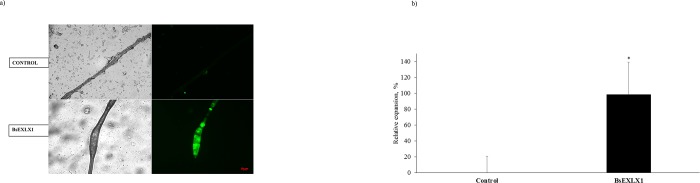
a and b. Effect of a recombinant bacterial expansin-like protein (BsEXLX1) on a) fluorescence microscopy images of cotton fibers treated with citrate buffer without (control) or with recombinant bacterial expansin-like protein (BsEXLX1) (300 μg/g cotton fibers) after incubation for 1 h in triplicate at 50°C and pH 4.0. Images on the left represent transmitted light illumination and, those on the right represent BsEXLX1 immunolocalization with a 20x objective. The scale bar represents 20 μm. b) Relative expansion of cotton fibers (expressed as a percentage of the value for the control). Samples were incubated in triplicate at 50°C and pH 4.0 for 1 hour. The concentration of BsEXLX1 was 300 μg/g of substrate. Symbol * denotes differences between treatments (P < 0.01; N = 3, Experiment 1).